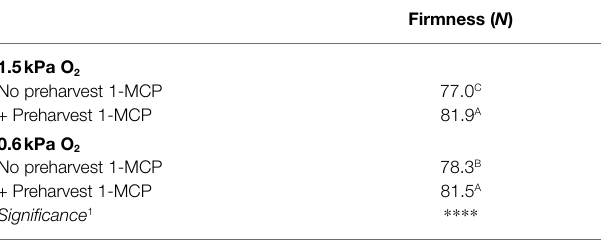
TABLE 2 | Firmness of ‘Gala’ apples treated without or with preharvest 1-methylcyclopropene (1-MCP) orchard spray at 7 days before harvest and then stored in 1.5 or 0.6 kPa O 2 + <0.5 kPa CO 2 at 0.5 ° C for 9 months in Year